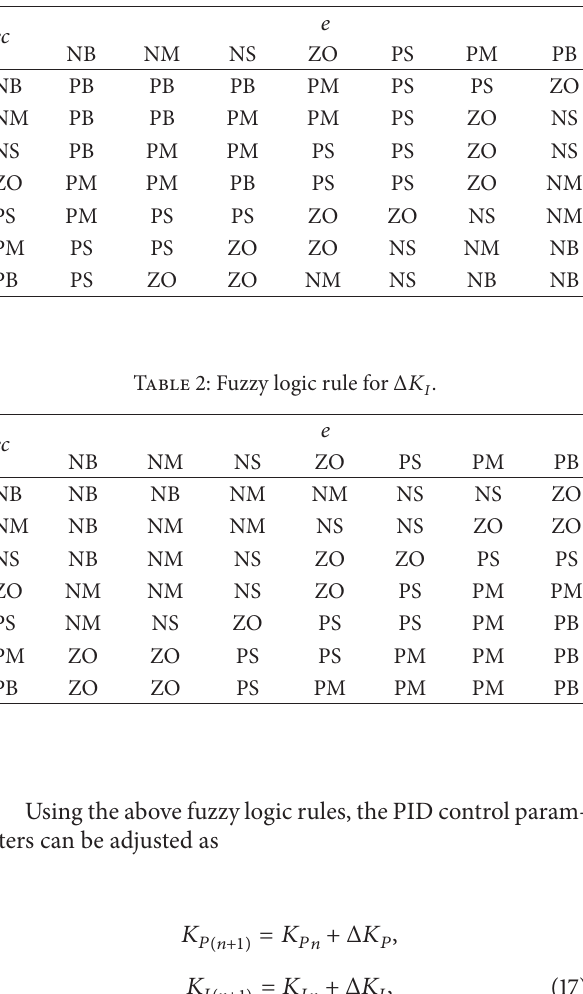
Table 1: Fuzzy logic rule for Δ𝐾 𝑃 .